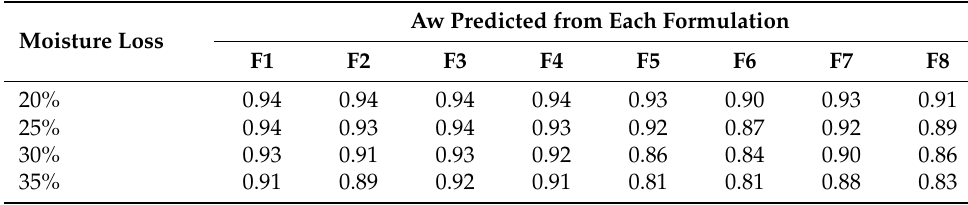
Table 5. Prediction of aw from possible moisture losses followed by the industry, using the eight equations obtained from each formulation.